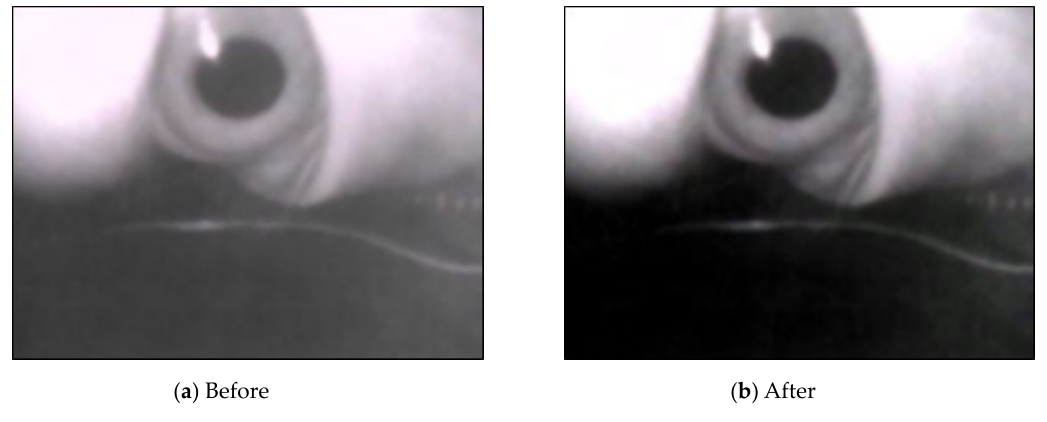
Figure 15. Results of the color balancing .